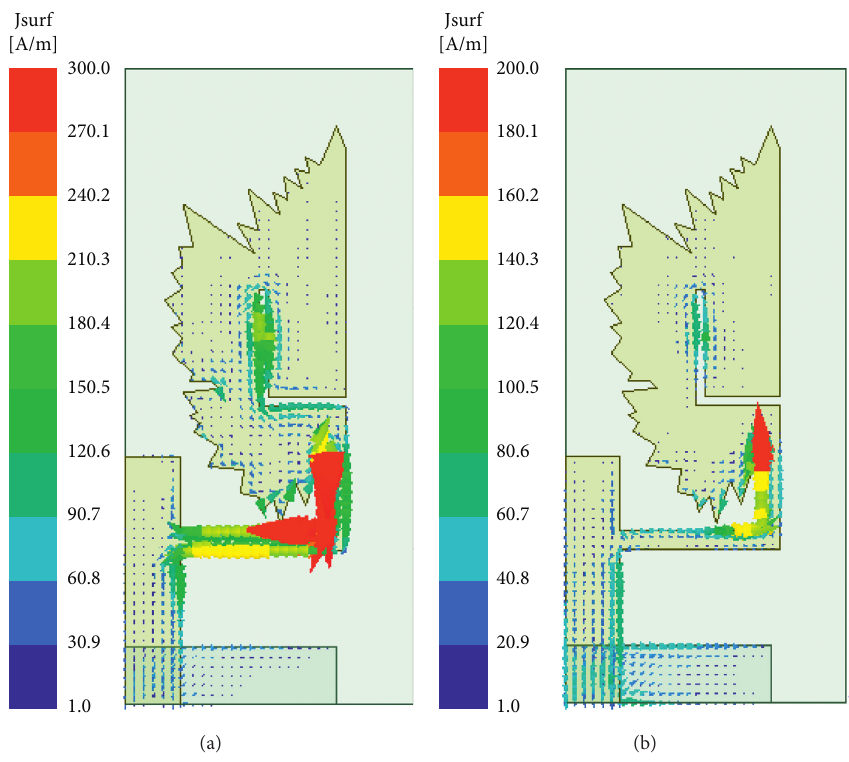
Figure 14: Distribution of surface current on Vine-leaf BioAs-MPA antenna at: (a) 2.5 GHz (TM